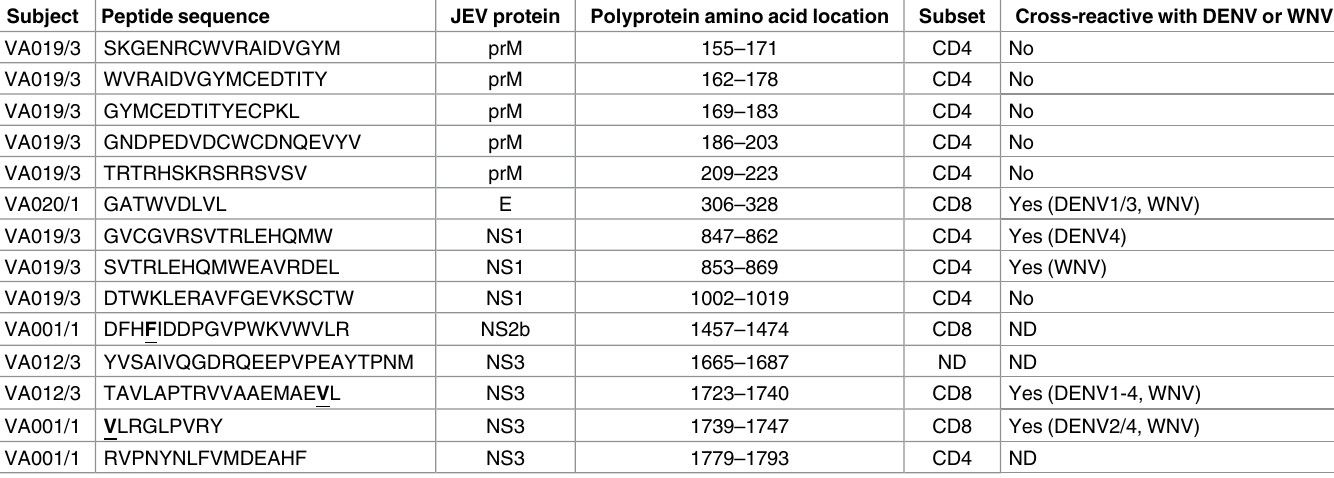
Cross-reactive responses to peptide sequences identified in JEV SA14-14-2 are shown. Amino acid differences between SA14-14-2 and JEV genotype III consensus are bold/underlined. ND = not determined, WNV = West Nile